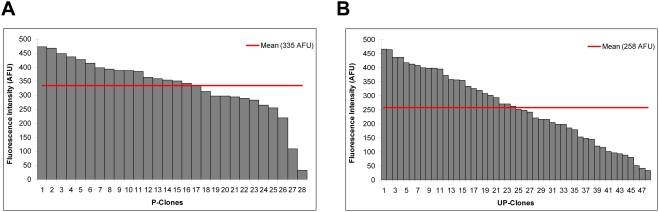
A) Distribution of fluorescence intensity in 28 P-clones in the undifferentiated state. B) Distribution of fluorescence intensity in 48 UP-clones in the undifferentiated state.
P- and UP-clones were created by transfecting ES cells using two different constructs: one with a basal Olig2 promoter upstream of GFP and the other with ULTRA placed in front of the Olig2 promoter and GFP. Integration events were selected by applying neomycin. Clones were expanded and analyzed for GFP expression by flow cytometry. The distributions of fluorescence intensity for P- and UP-clones were statistically different (P-value<0.05, Wilcoxon rank sum test).